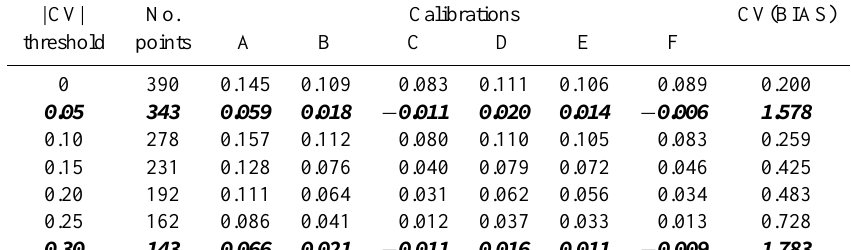
Table 4. BIAS calculated with removed data points for the different calibrations.